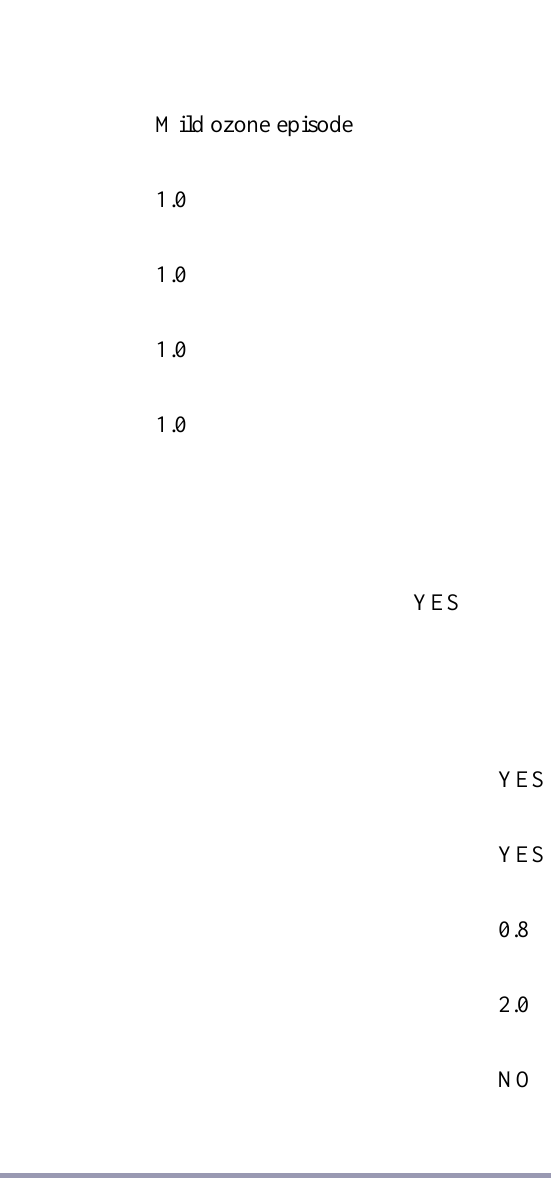
Table E. Air quality conditions.